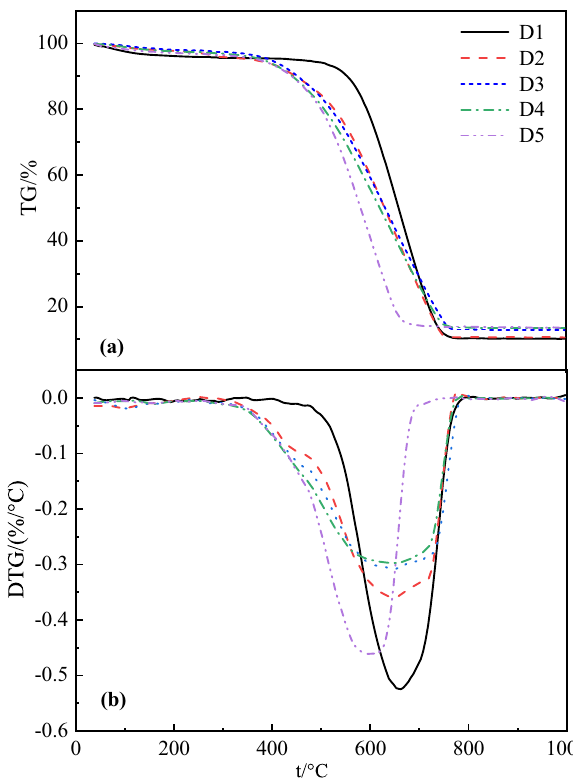
Figure 1: TG – DTG curves of the samples at the temperature rise rate of 20°C/min: ( a ) TG and ( b ) DTG curves.